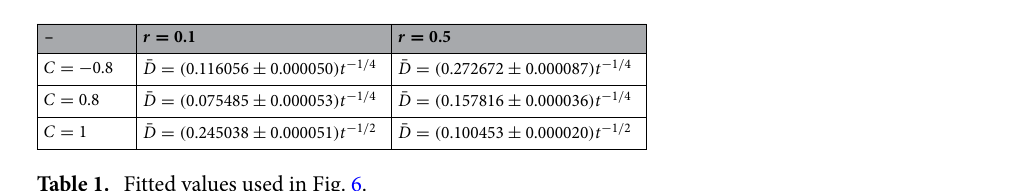
Table 1. Fitted values used in Fig.